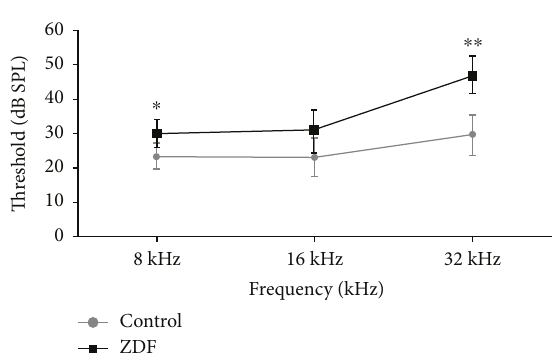
Figure 1: ABR thresholds of rats in the ZDF and control groups at 36 weeks. Data are expressed as the mean ± SD ( n = 6 ). ∗ P < 0 05 and ∗∗ P < 0 01